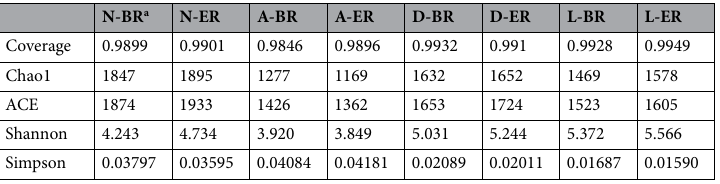
Table 1. Sequencing information and diversity index under 97% similarity. a N normal group, A acid group, D DCD group, L low temperature group, BR blank reactor, ER experiment